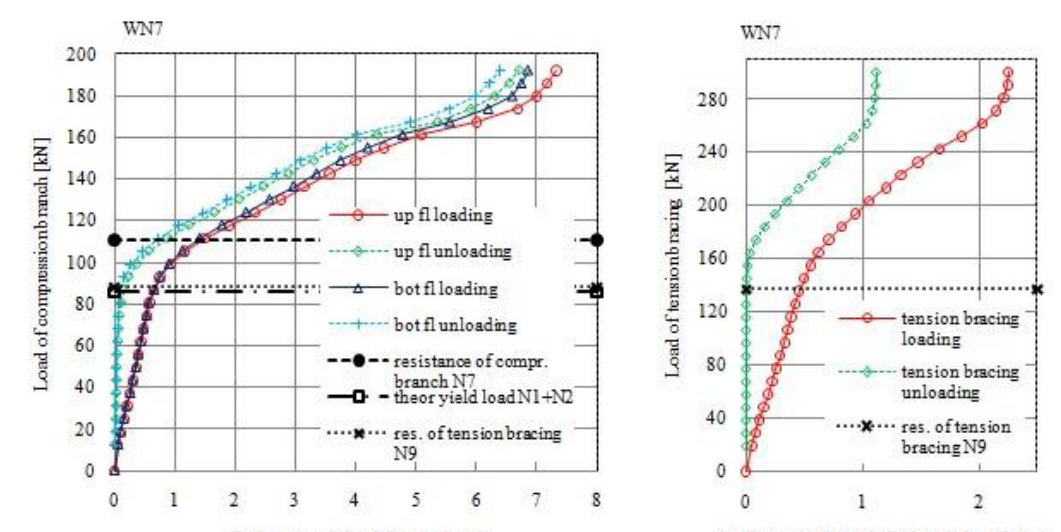
placements of samples. The load and displacements of ver- tical compressed branch and